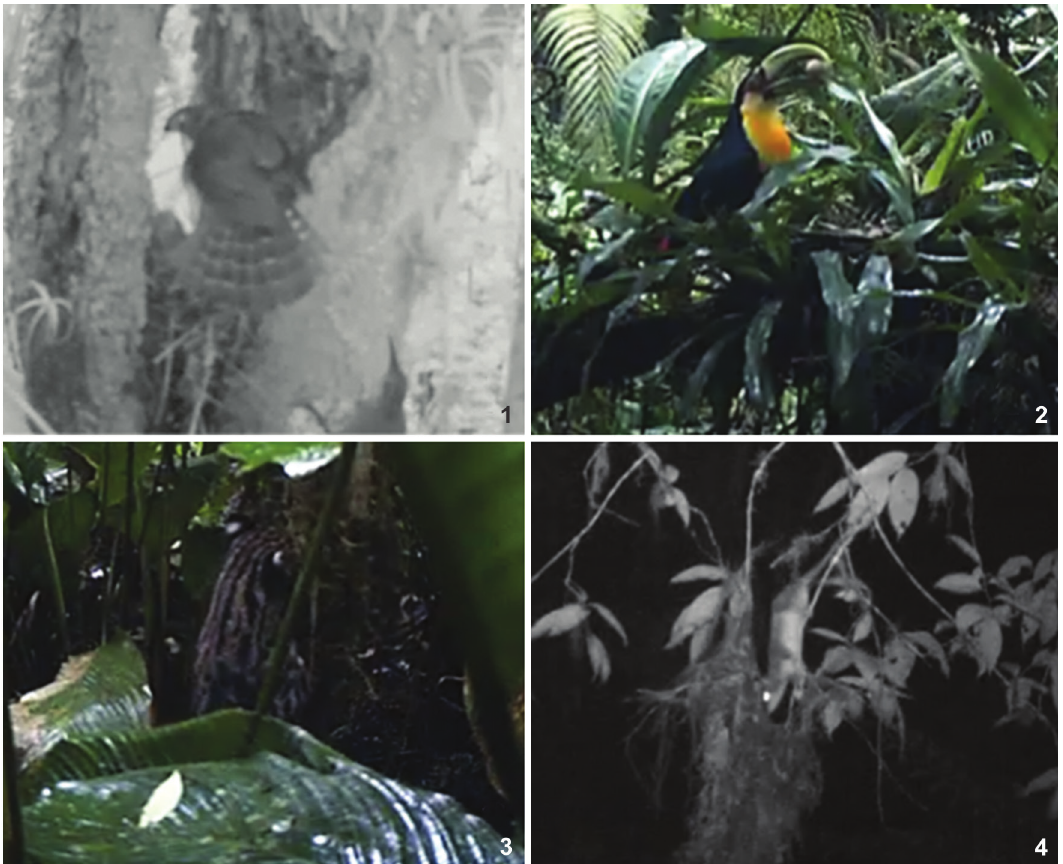
Figures 1–4. Predators of bird nests recorded with camera traps in an area of Atlantic rainforest. (1) the Collared Forest-falcon, Micrastur semitorquatus , depredating a nest of the White-necked Thrush, Turdus albicollis . (2) the Red-breasted Toucan, Ramphastos dicolorus , dep- redating a nest of the Ruddy Quail-dove, Geotrygon montana . (3) the Ocelot, Leopardus pardalis , depredating a nest of the Gray-hooded Flycatcher, Mionectes rufiventris . (4) the Gray Slender Mouse Opossum, Marmosops incanus depredating a nest of the Royal Flycatcher, Onychorhynchus swainsoni